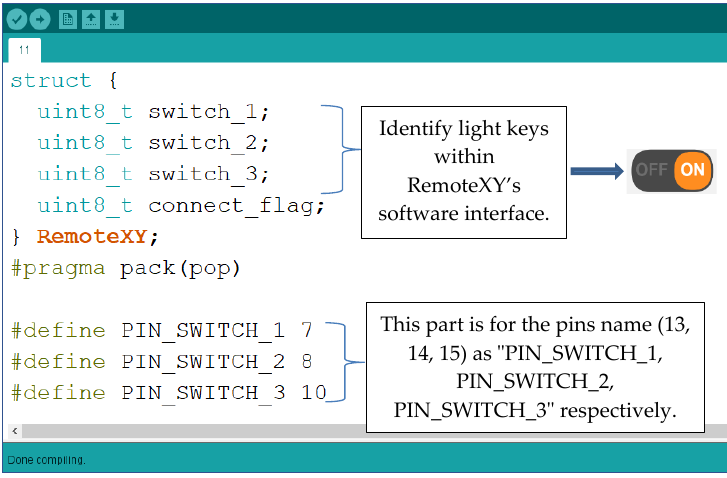
Figure A2. The second part of the executed code used to control lighting and sockets.